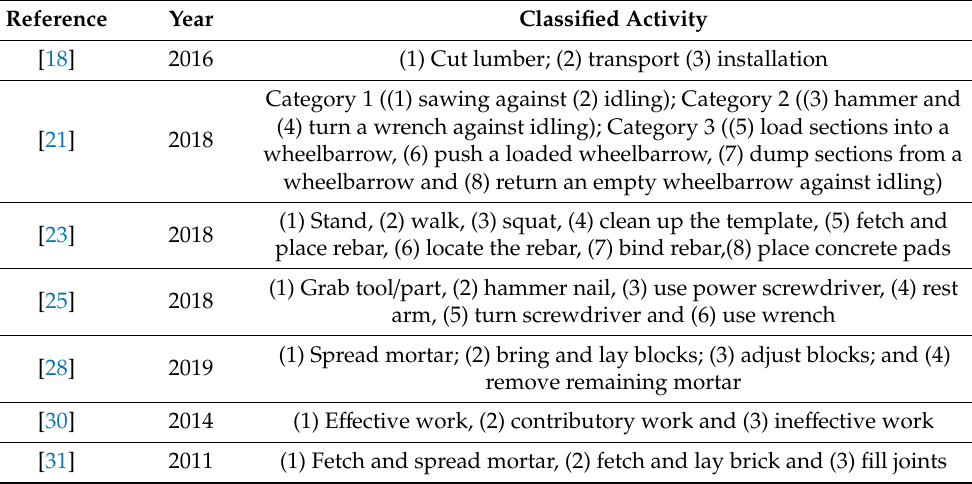
Table 2. Studies conducted for di ff erent types of activity